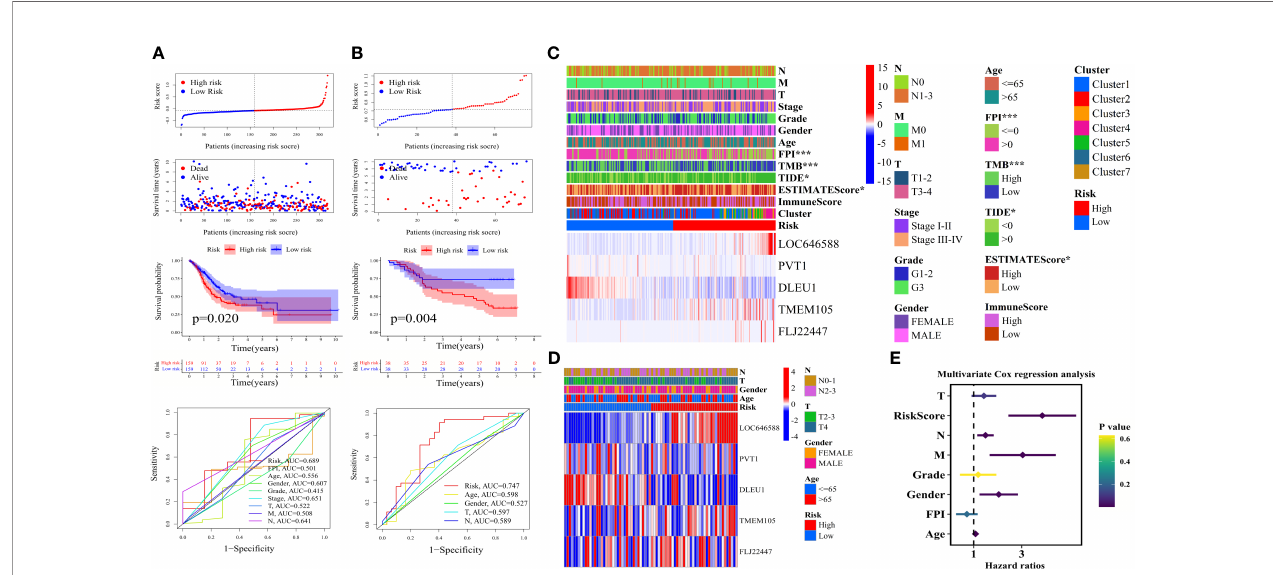
FIGURE 3 | Construction of ferroptosis-related ncRNA signature, clinical correlation analysis, and independent prognosis analysis. Grouped according to the median value of risk score, distribution of survival status and risk score, Kaplan – Meier survival curves, and clinically relevant ROC curves of (A) The Cancer Genome Atlas — stomach adenocarcinoma (TCGA-STAD) cohort and (B) the GSE84426 cohort. Correlation analysis of clinical characteristics by chi-square test and heat maps of fi ve ferroptosis-related ncRNAs of (C) TCGA-STAD cohort and (D) the GSE84426 cohort. (E) Forest plot showing the P -values, hazard ratios of the clinical characteristics of TCGA-STAD from multivariate Cox regression analysis. ROC, receiver operating characteristic. *P < 0.05; ***P <